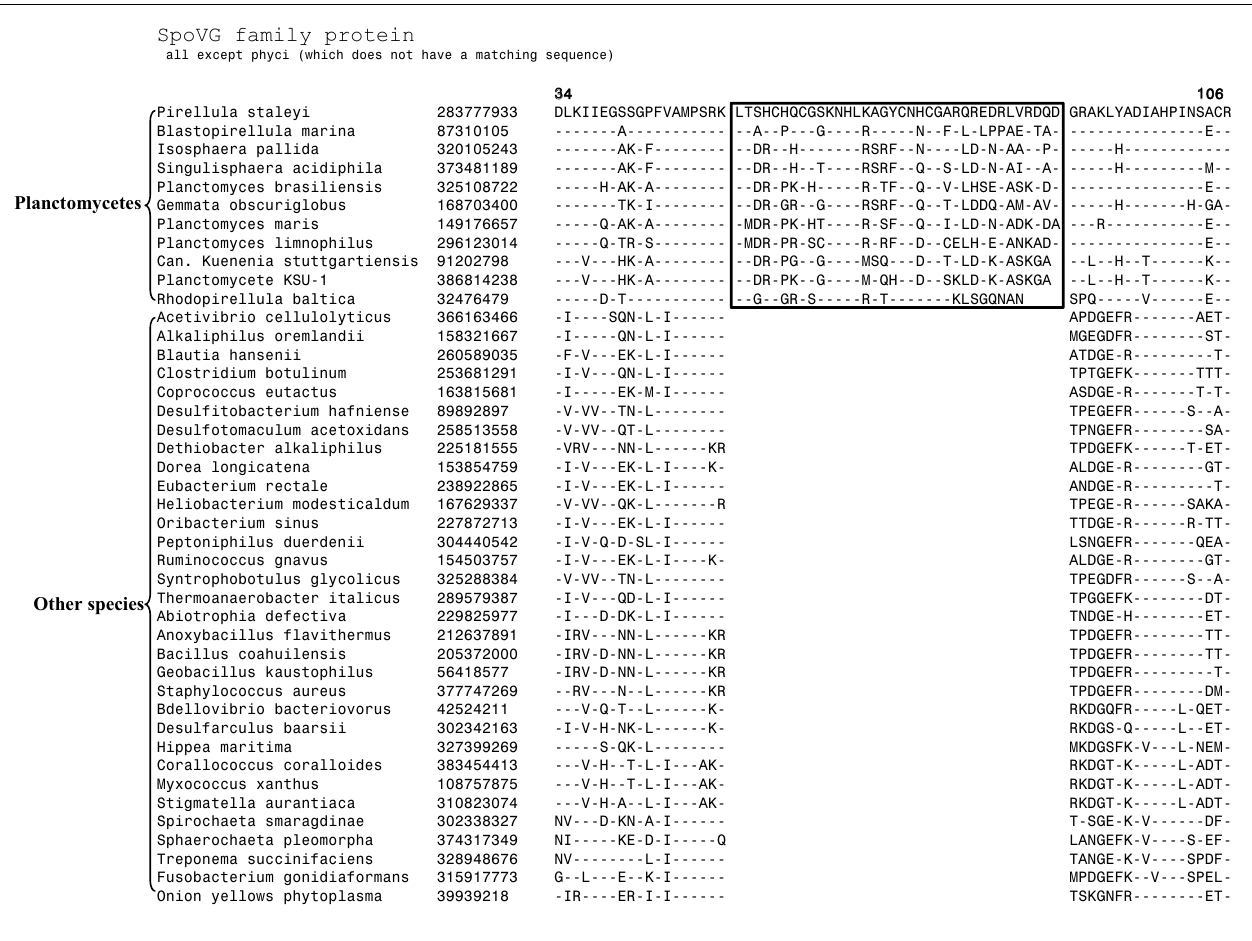
FIGUREA3 |A large, 32–36 aa insert present in all detected species of the Planctomycetes species is presented. The conserved region is present within a conserved region of the SpoVG family protein and is not found in any organism outside of the Planctomycetes